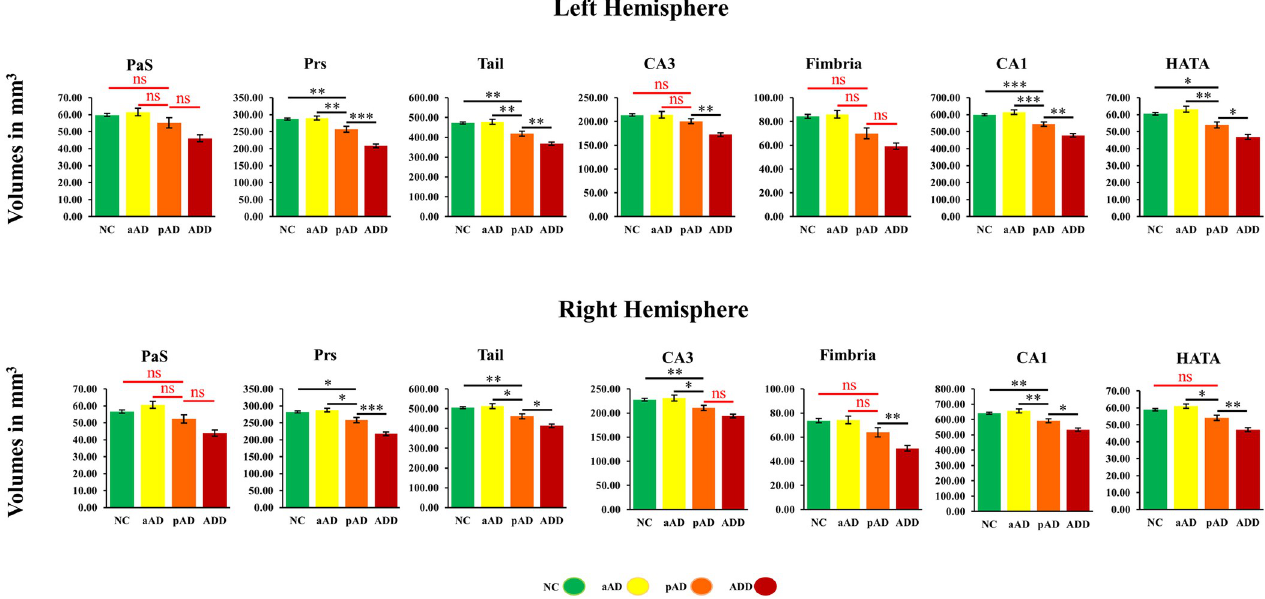
Fig 1. Hippocampal subfield volumes in NC, aAD, pAD, and ADD groups adjusting for the covariates age, sex, level of education, and intracranial volume. Error bars indicate two standard errors. There were seven prominent regions among the entire 13 regions. NC, normal controls; aAD, asymptomatic Alzheimer Disease; pAD, prodromal Alzheimer Disease; ADD, Alzheimer Disease Dementia; n.s, not statistically significant; � , p < 0.05; �� , p < 0.01; ��� , p < 0.001.